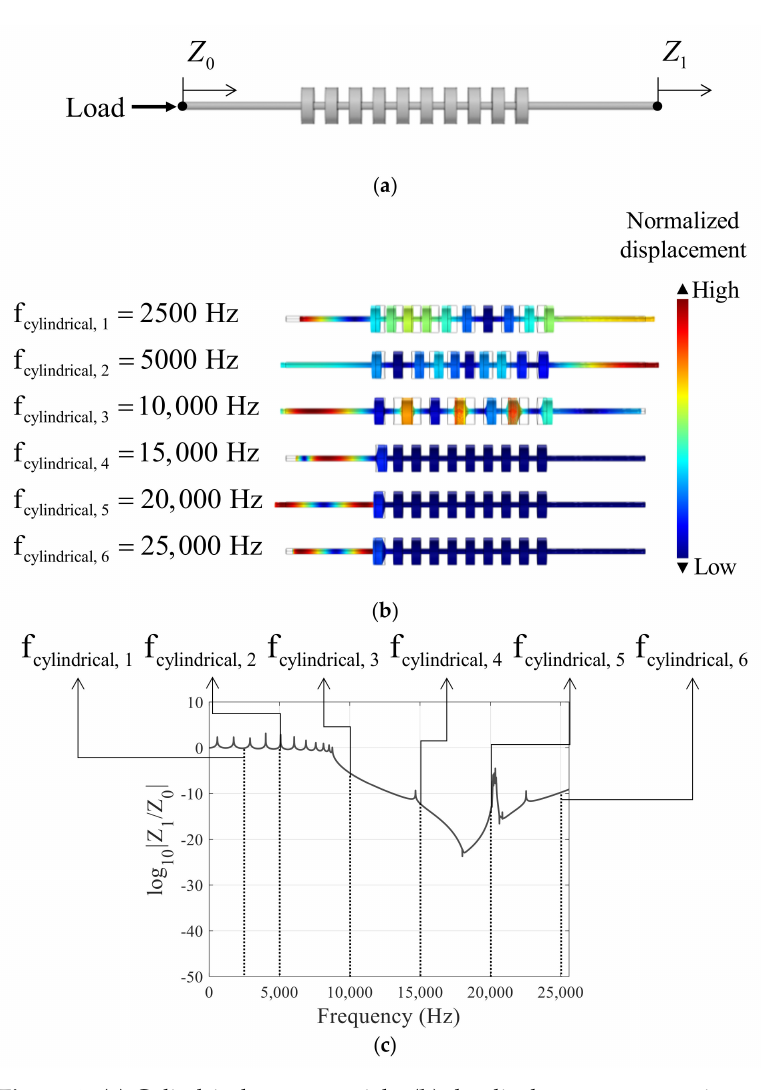
Figure 4. ( a ) Cylindrical metamaterials, ( b ) the displacement at certain and ( c ) the frequency re-